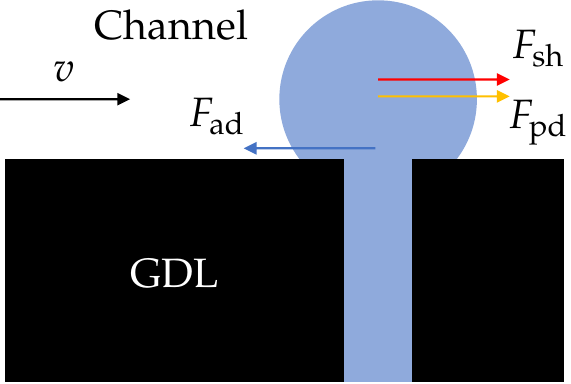
Figure 2. Sketch of the forces acting on a droplet. The geometry of an average droplet is necessary to calculate the acting forces. The reduced water saturation: